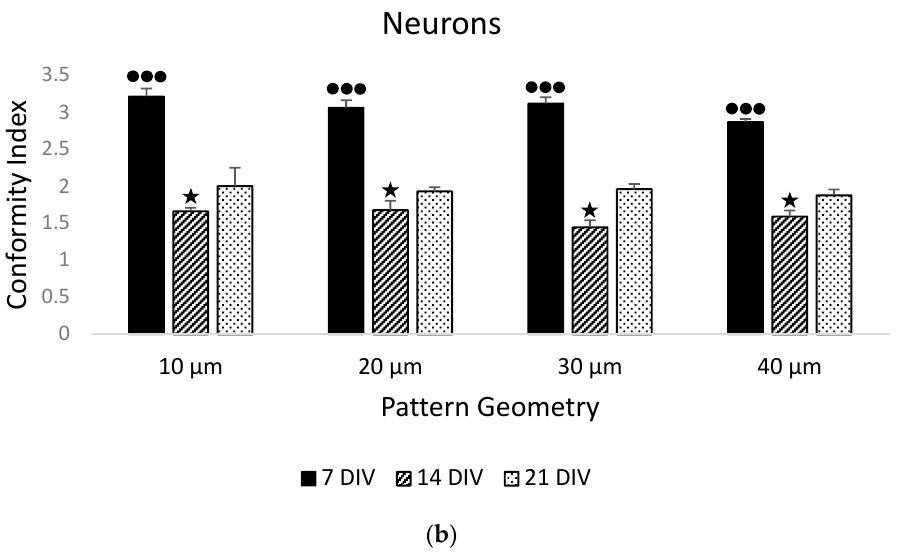
Figure 5. Bar graphs of the conformity index of: ( a ) hippocampal astrocytes (GFAP + ) and ( b ) hippocampal neurons (TUJ1 + ) patterned on parylene-C. Black bars denote the average CIs of the 7 DIV culture samples ( N = 3), striped bars denote the average CIs of the 14 DIV culture samples ( N = 3) and dotted bars denote the average CIs of the 21 DIV culture samples ( N = 4). Results highlight the loss of conformity to the patterns as the culture time progressed, as well as the narrowest geometry (10 μ m) being superior in guiding astrocytic migration and growth. Three dots denote significance at p < 0.001 between respective groups. The star denotes significance at p < 0.001 between 14 and 21 DIV. Error bars represent the standard error of the mean (SEM).